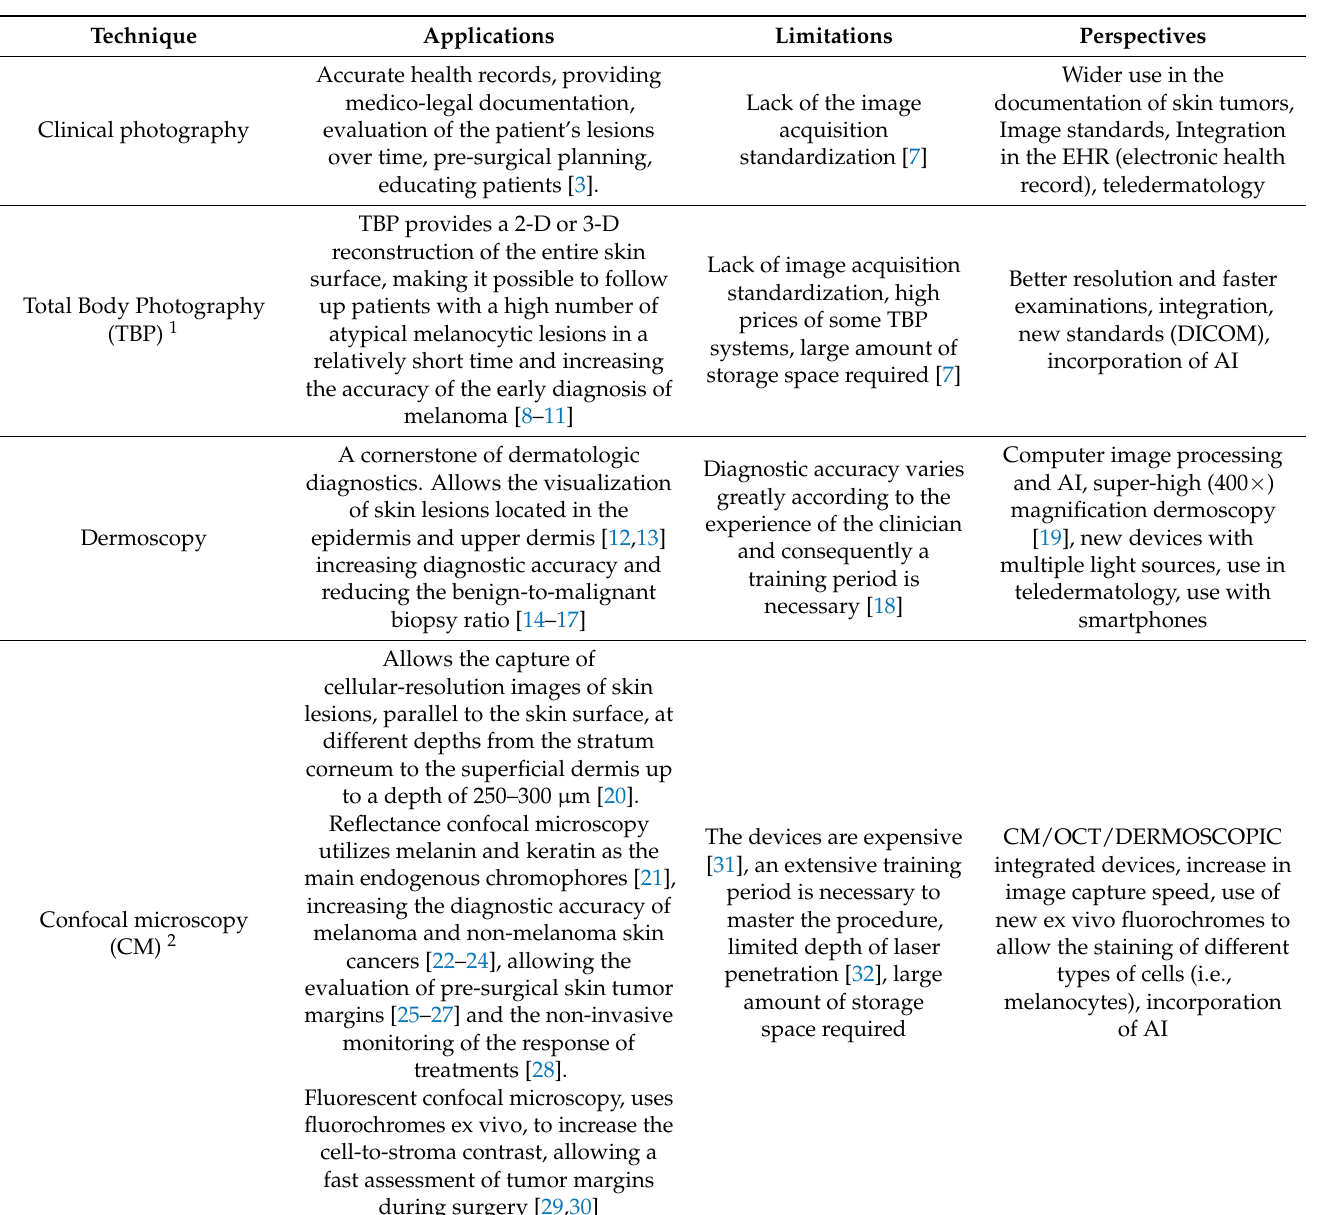
Table 1. In vivo technologies in dermatological